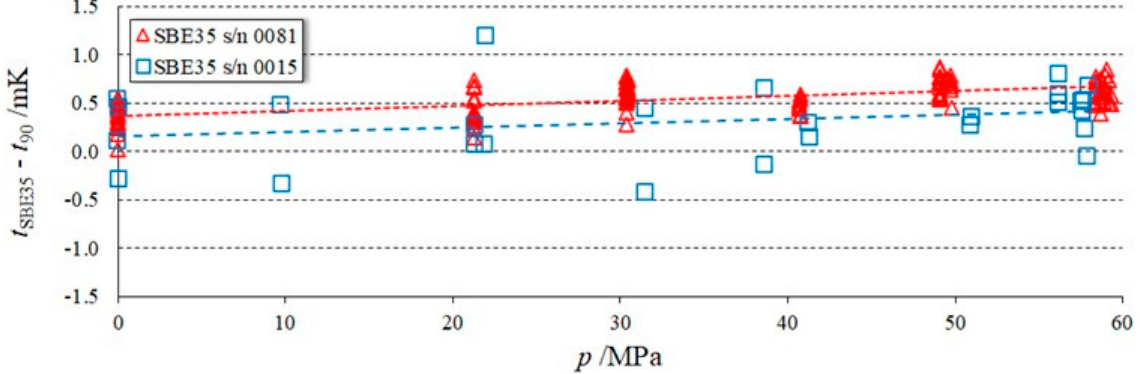
Figure 10. Temperature difference between the SBE35 reading and the reference thermometers as a function of the pres- sure.